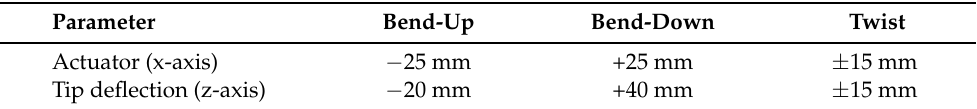
Table 3. Allowable movement ranges specified and set by the calibration procedure to adhere to the structural design limits. This pertains to the actuator (x-axis) and the deflection of the wing tip (z-axis).